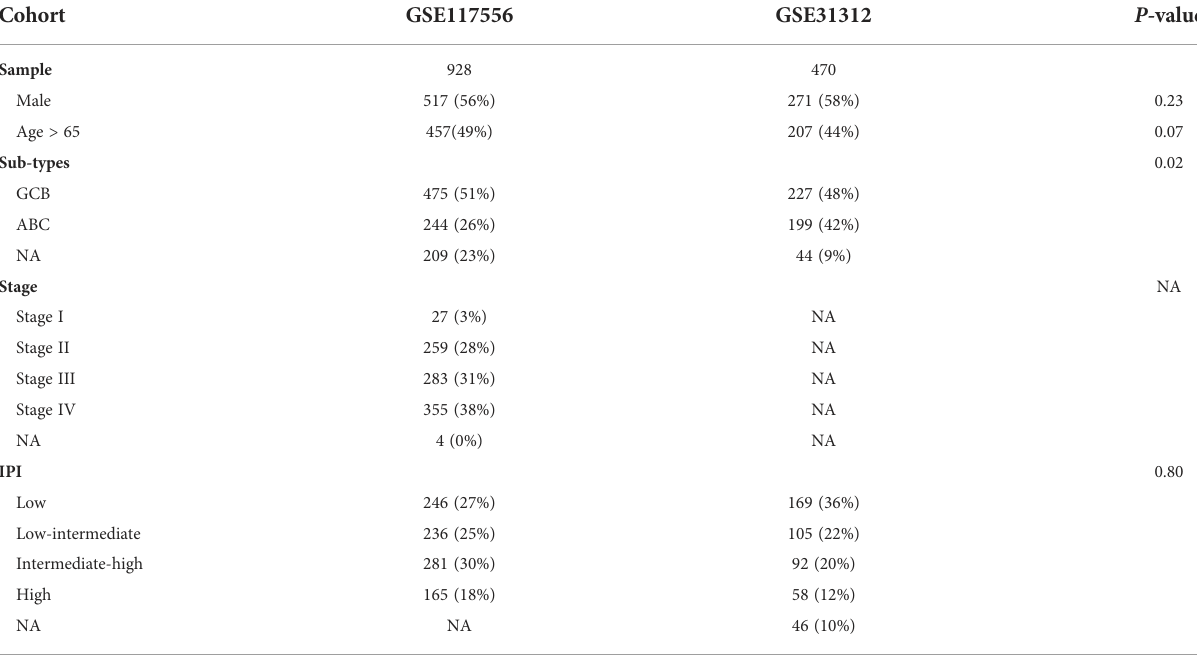
TABLE 1 Distribution of clinical